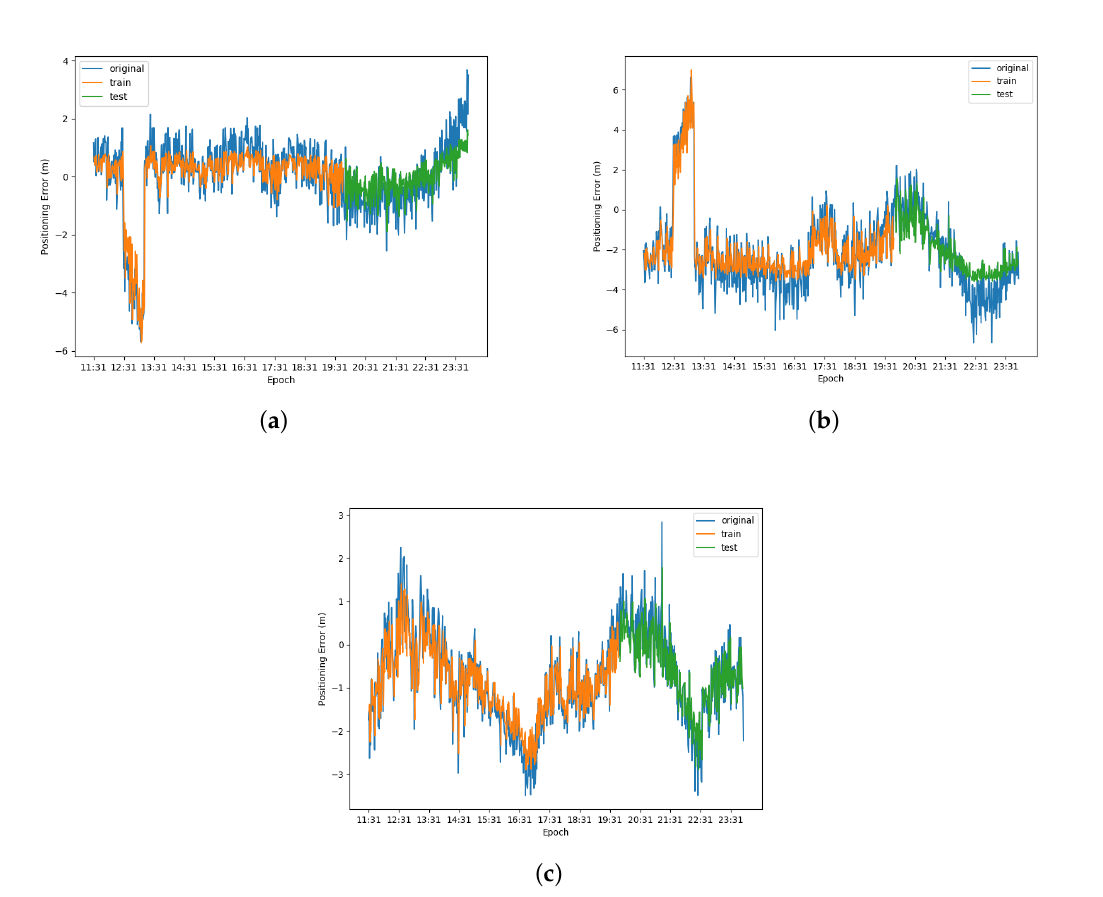
Figure 10. Result of LSTM error prediction performed on the weighted least square method: ( a ) result on X-axis; ( b ) result on Y-axis; and ( c ) result on Z-axis.